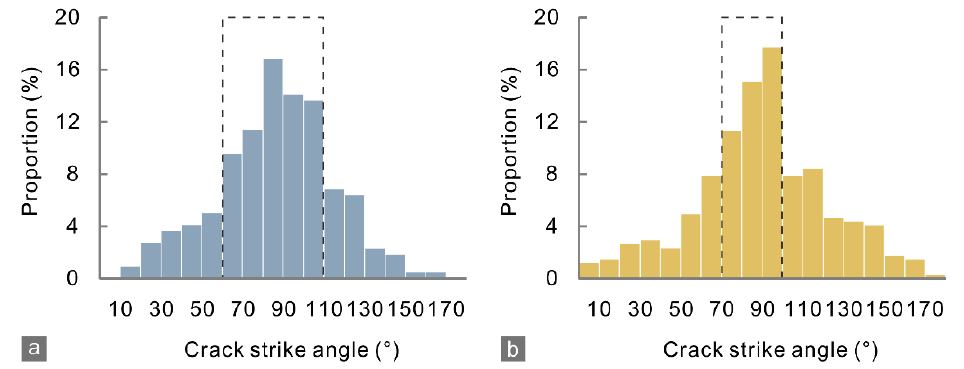
Figure 14. Strike angle distribution of micro-cracks in the CCNBD simulations for ( a ) marble A and ( b ) J, corresponding to Figures 10b and 11b. The dashed boxes define the main distribution ranges.